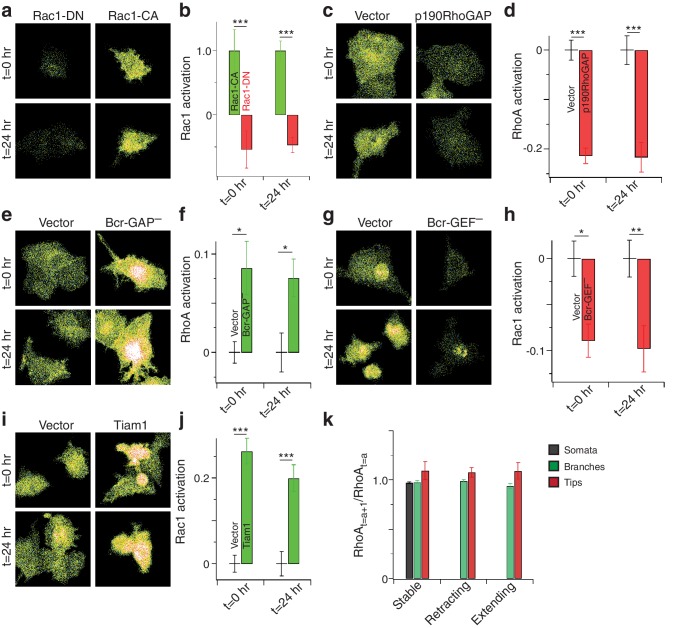
Long-term measurements of Rho-GTPase activation.Raichu probes and RhoA-FLARE are generally used for short-term measurements, though they are in principle able to be calibrated (e.g., Palmer et al., 2004) and measurements from 10 hr up to 8 days have been reported (Kim et al., 2014; Konopka et al., 2016; Timpson et al., 2011). (a) Representative images of Cos-7 cells expressing Raichu-RhoA with the RhoA moiety mutated such that it is dominant negative (DN) or constitutively active (CA) taken from the same pool of cells 24 hr apart. (b) Summary data for this experiment. (N = 3, n = 30). (c) Representative images of Cos-7 cells expressing Raichu-RhoA and empty vector or the RhoA-GAP p190RhoGAP taken from the same pool 24 hr apart. (d) Summary data for this experiment. (N = 3, n = 80 for t = 0 hr and 60 for t = 24 hr) (e) Representative images of Cos-7 cells expressing Raichu-RhoA and empty vector or a Rac1-GAP-dead mutant of Bcr (i.e., a functional RhoA-GEF only) taken from the same pool of cells 24 hr apart. (f) Summary data for this experiment. (N = 3, n = 60 for t = 0 hr and 80 for t = 24 hr) (g) Representative images of Cos-7 cells expressing Raichu-Rac1 and empty vector or a RhoA-GEF-dead mutant of Bcr (i.e., a functional Rac1-GAP only) taken from the same pool of cells 24 hr apart. (h) Summary data for this experiment. (N = 3, n = 80) (i) Representative images of Cos-7 cells expressing Raichu-Rac1 and empty vector or the Rac1-GEF Tiam1 taken from the same pool of cells 24 hr apart. (j) Summary data for this experiment. (N = 3, n = 80 for t = 0 hr, 60 for vector t = 24 hr and 50 for Tiam1 t = 24 hr) (k) Summary data showing the quotient between measurements separated by 1 hr, taken from the experiments shown in Figure 3d–i at 18 DIV. These data show stability on a shorter time course that is comparable to the longer-term data that is presented in Figure 3. This is preserved across stable, retracting, and extending pools of dendrites and somata. (N = 5, n = 74 for somata, 115 for stable branches, 106 for stable tips, 134 for retracting branches, 131 for retracting tips, 96 for extending branches, and 94 or extending tips) Together, these data show that measurements are reasonably stable over 24 hr. Data are represented ± s.e.m. (***p<0.0001, **p<0.01, *p<0.05) Detailed statistics are found in Figure 3—figure supplement 1—source data 1.10.7554/eLife.47566.019Figure 3—figure supplement 1—source data 1.Statistical summary for Figure 3—figure supplement 1: ANOVA and key Tukey post-hoc tests and N and n values for Figure 3—figure supplement 1b,d,f,h,j.